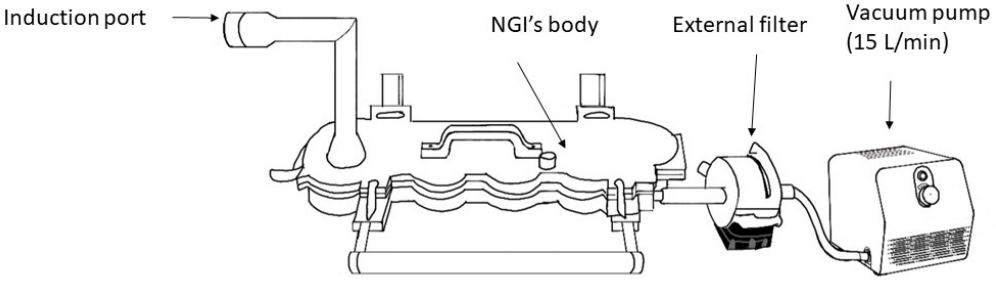
Figure 4. Next Generation Impactor (NGI).